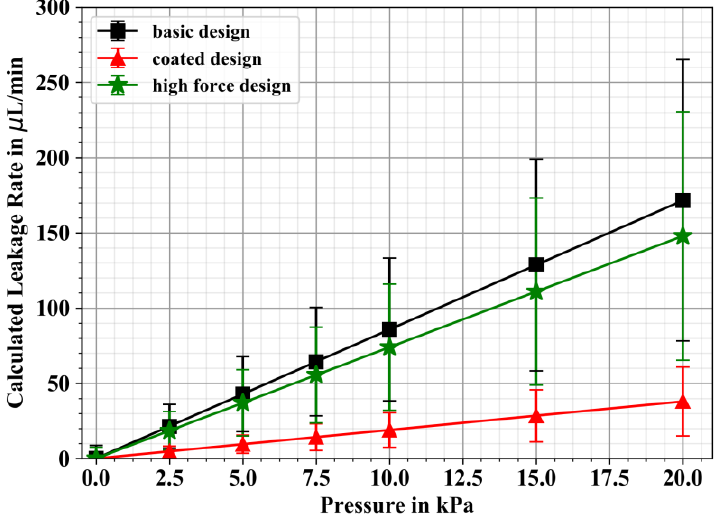
Figure 8. Analytically modelled pressure-dependent leakage rates for the three microvalve variants. Error bars show standard deviations based on calculated propagation of uncertainty of manufacturing and material tolerances.